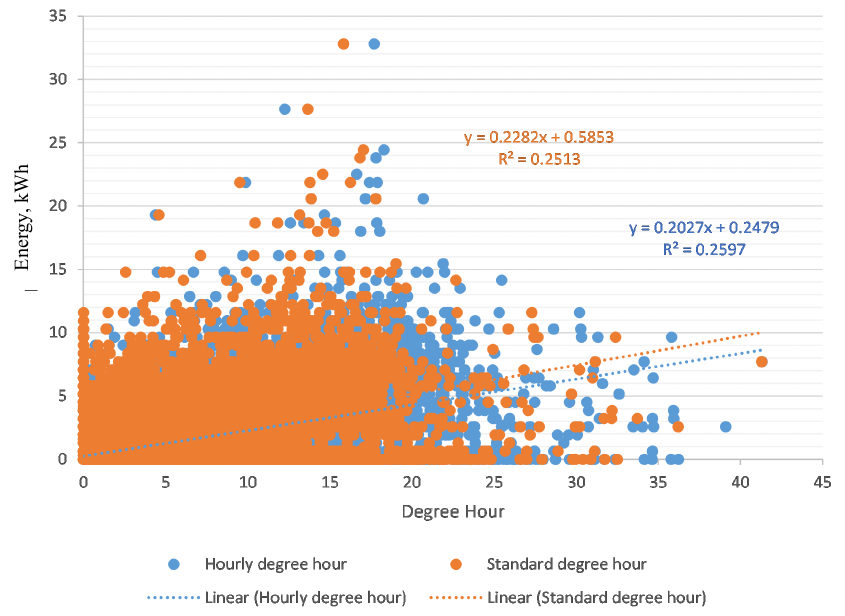
Fig. 1. Energy consumption versus degree-days for house 1 with hourly